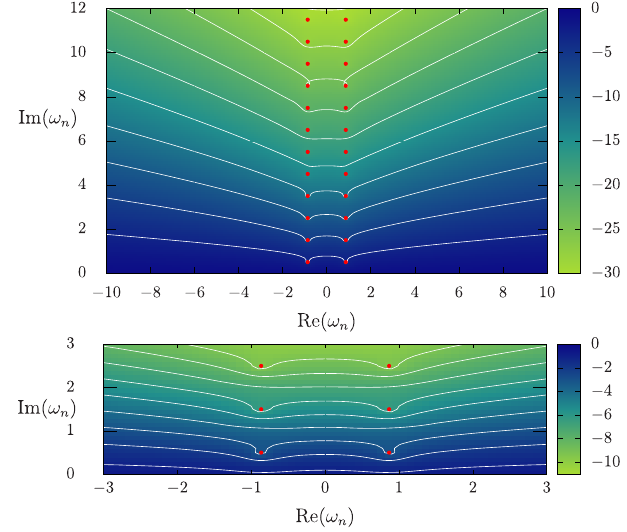
FIG. 5. Top panel: pseudospectrum for the Pöschl-Teller potential. QNMs (red circles) from Fig. 3 are superimposed, for reference, on their (in)stability. The color log scale corre- sponds to log 10 ϵ , with white lines indicating the boundaries of ϵ -pseudospectra sets σ ϵ , whose interior extends upwards in the ω - complex plane. Bottom panel: zoom into the region around the fundamental QNM and first